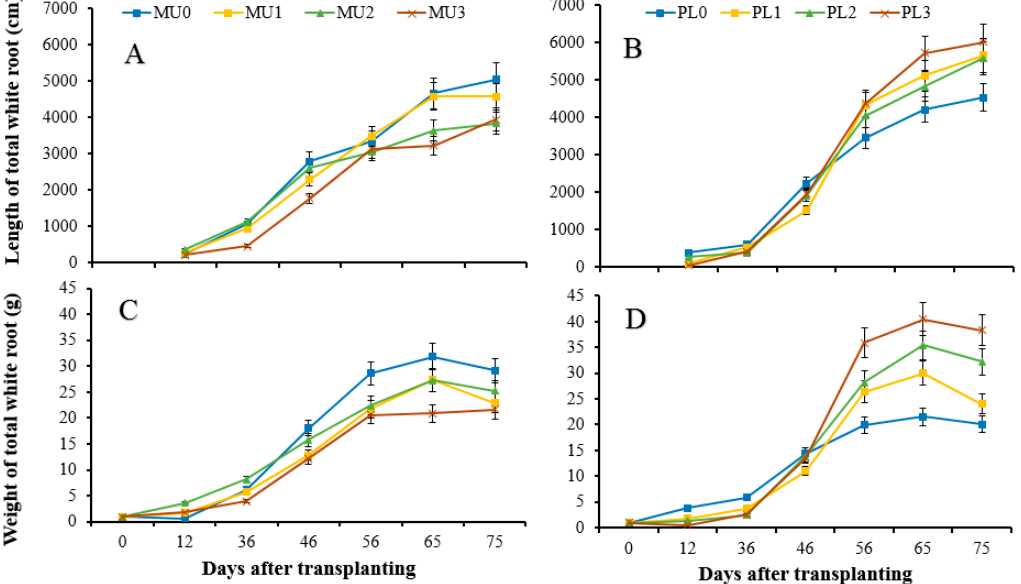
Figure 5. Comparison of total length and weight of white root in rice fields under different oilseed rape straw-returning treatments. MU 0 , MU 1 , MU 2 , and MU 3 represent 0.0 t/hm 2 , 1.5 t/hm 2 , 3.0 t/hm 2 , and 4.5 t/hm 2 of straw, respectively, which were incorporated in the soil by a mulching method. Whereas PL 0 , PL 1 , PL 2 , and PL 3 represent 0.0 t/hm 2 , 1.5 t/hm 2 , 3.0 t/hm 2 , and 4.5 t/hm 2 of straw, respectively, which were incorporated in the soil by a plowing method. A and B are the total length of white root under mulching and plowing treatment respectively; C and D are the fresh weight of white root for mulching and plowing treatment respectively.